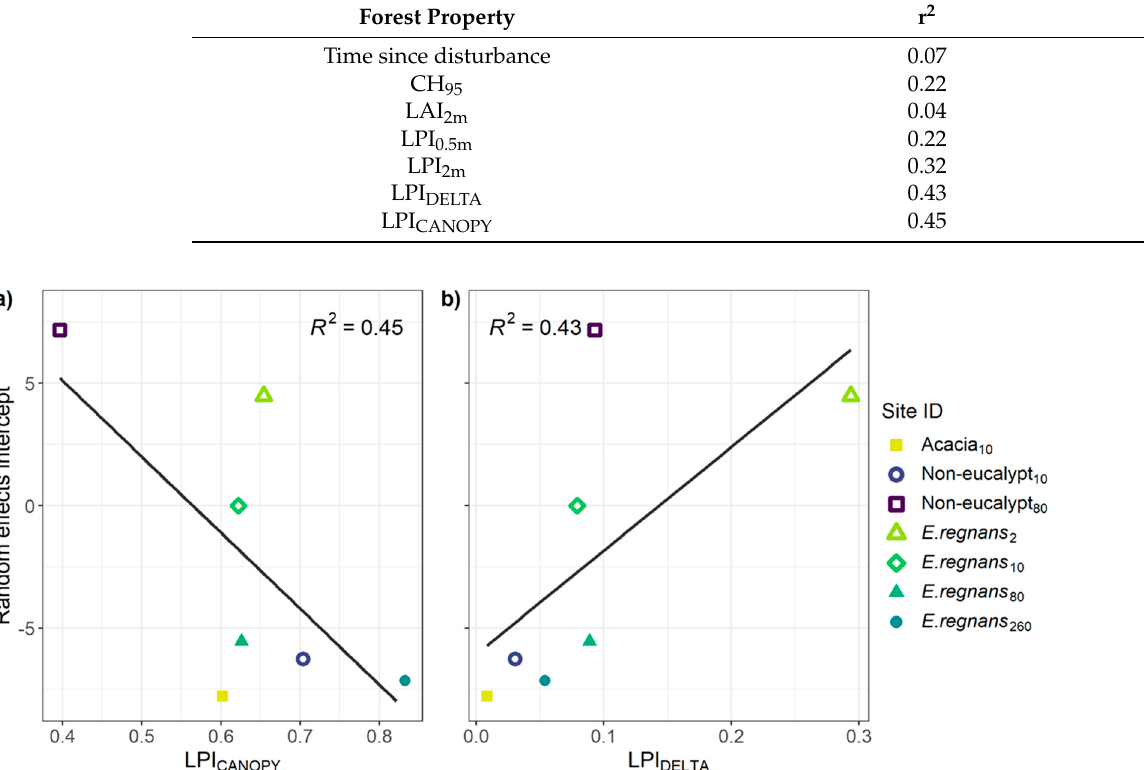
Figure 8. Simple linear regressions plots of the best performing forest structural properties to predict GAMM INDP random (site) effects intercepts for ( a ) LPI CANOPY and ( b ) LPI DELTA .